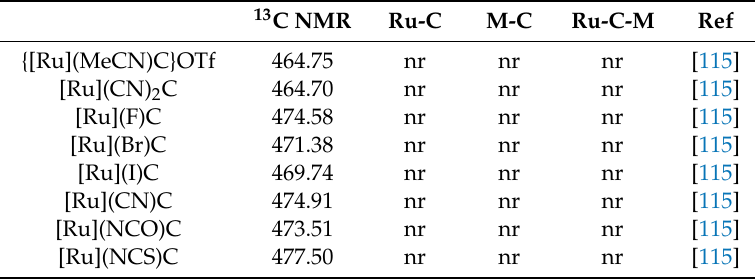
Figure 26. Carbido compounds of [Ru]XC with various X. Table 15. Carbido complexes with the [Ru]XC core. Table 15. Carbido complexes with the [Ru]XC core.